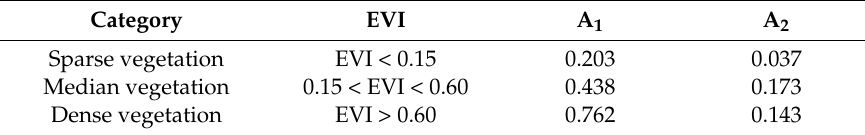
Table 3. The statistical mean values of A 1 and A 2 for three vegetation